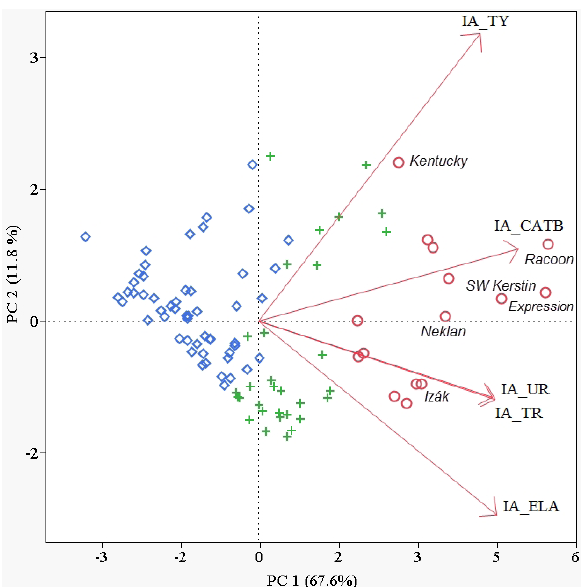
Figure 7: Distribution of oats according to protease inhibitory activities to trypsin (IA_TY), thrombin (IA_TR), urokinase (IA_UR), elastase (IA_ELA), and cathepsin B (IA_CATB) (Field 2, Fig. 1). Colors and symbols of samples are the same as in cluster analysis (Fig. 8).